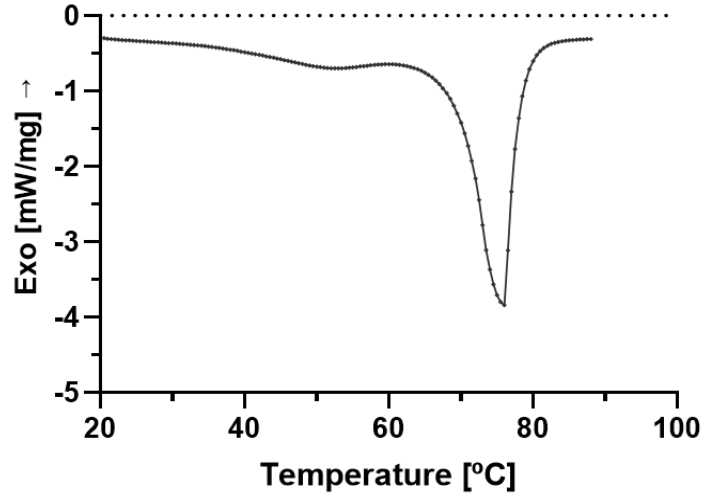
Figure 5. Differential scanning calorimetric profile of bulk Compritol, depicting a melting peak at 75.8 °C, with an onset temperature of 61.8 °C and end set at 84.4 °C.